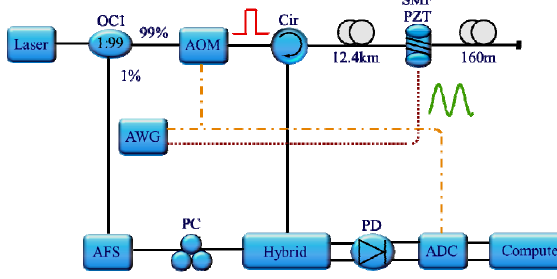
Fig. 14 Experimental setup of coherent detection Φ -OTDR based on homodyne detection